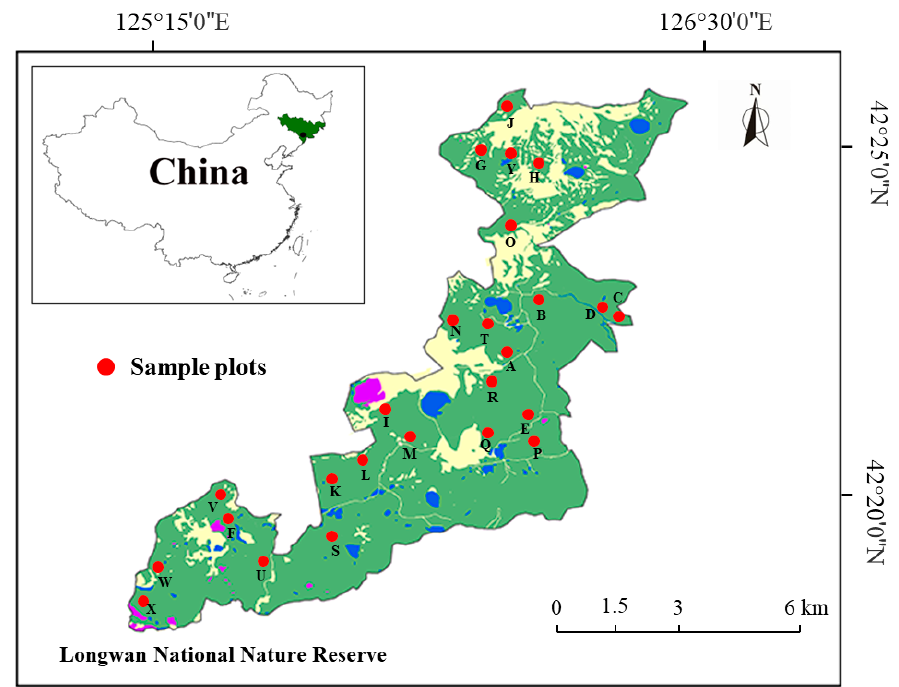
Figure 1. Distribution of survey sample plots in the Longwan Nature Reserve.